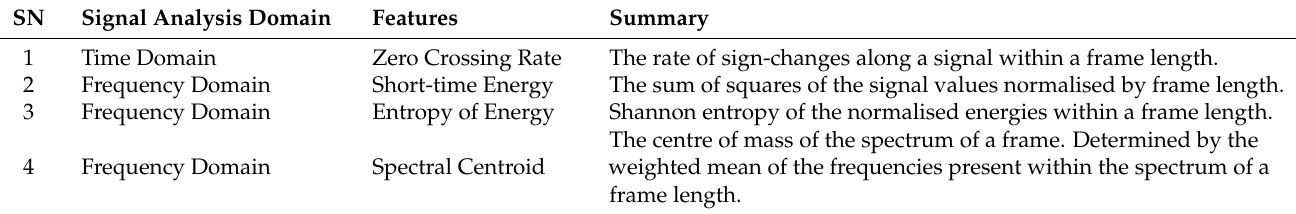
Table 4. Feature extraction parameters